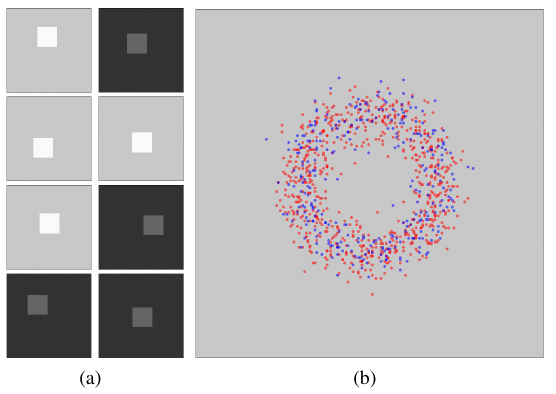
Figure 3. (a) Examples from the training dataset. (b) Distributions of the square center positions in the training (red) and validation (blue) dataset used for model